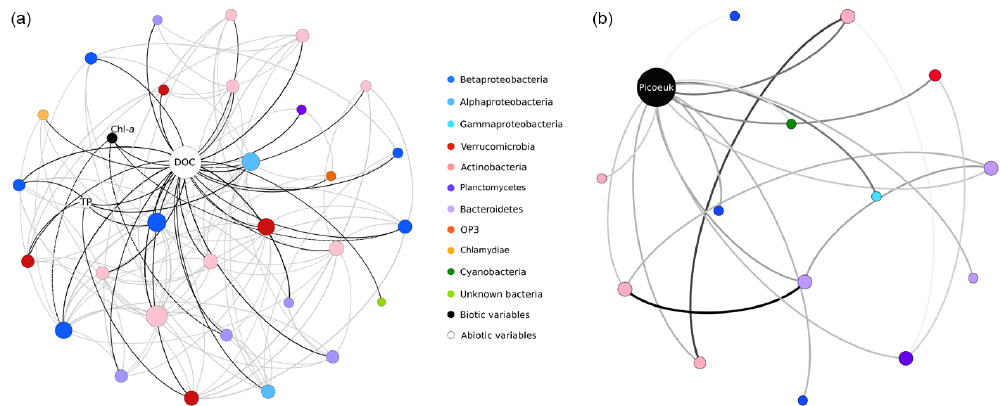
Figure 3. Subnetworks organized around DOC (a) and phototrophic picoeukaryotes (b) . Subnetworks were extracted from the entire co- occurrence network (Fig. S5). In (a) , edge color refers to the type of relationship with significant connection between OTUs and both biotic and abiotic variables presented in black, whereas relationships between bacterial taxa are presented in grey. In (b) , edge color is proportional to the association strength, with strong associations shown in black. The size of the nodes is proportional to node degree (the number of connections that a node has with other nodes).